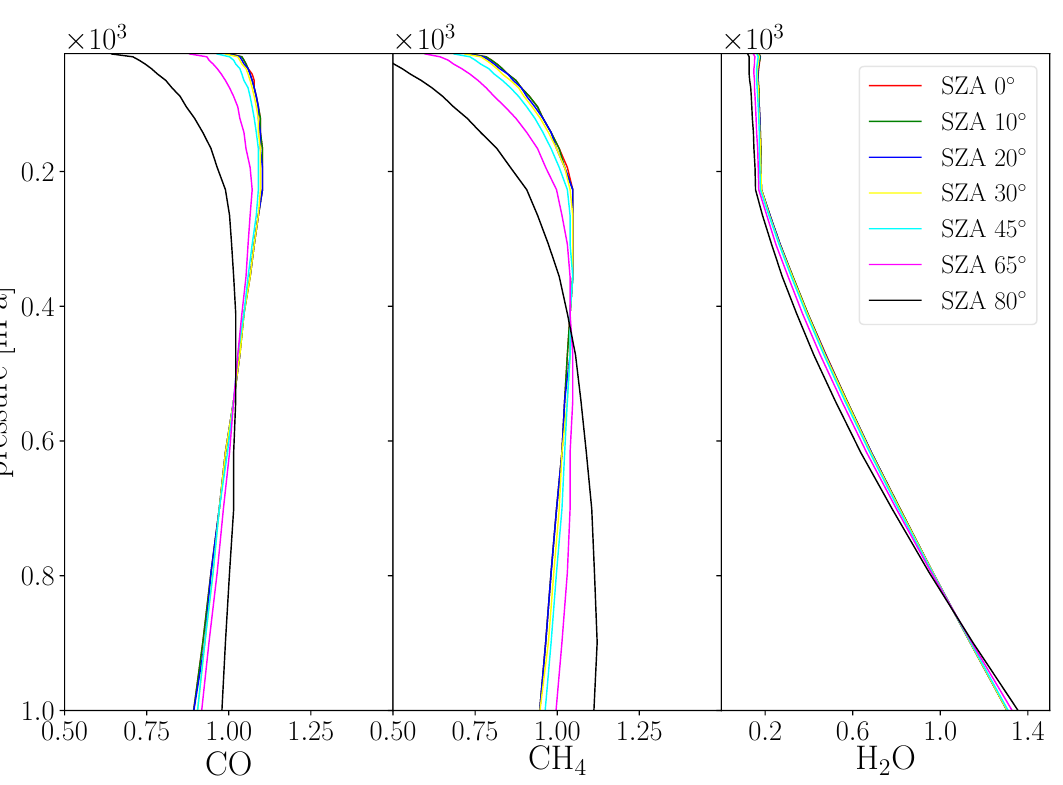
Figure 8. Total column averaging kernels for the BIRRA CO retrieval [4277.20–4302.90 cm − 1 ] in the nadir viewing geometry. The target molecule CO as well as CH 4 reveal a kernel close to unity up to 200hPa. Measurements with an SZA > 80 ◦ are not considered in the